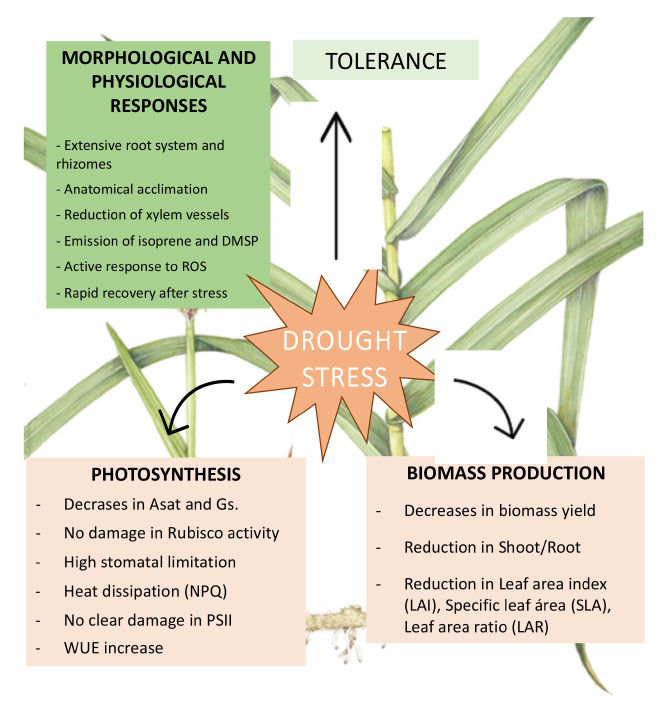
Figure 1. Summary figure describing the main findings of the study. Asat: photosynthetic assimila- tion rate; Gs: stomatal conductance; NPQ: non-photochemical quenching; PSII: photosystem II; WUE: water use efficiency; DMSP: dimethylsulfoniopropionate; ROS: reactive oxygen